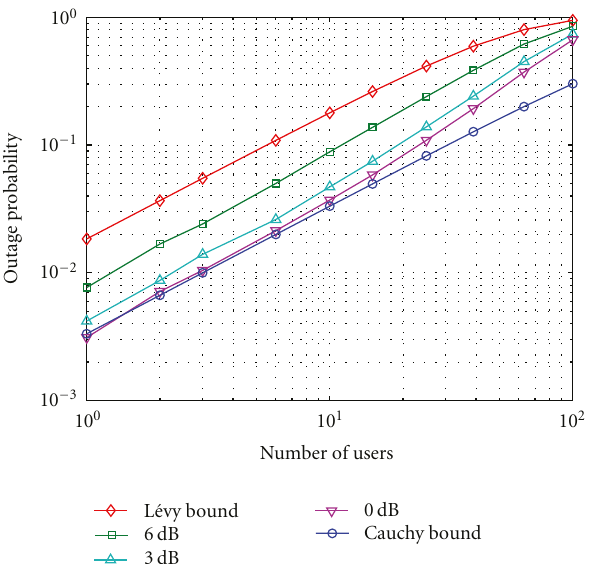
Figure 4: The outage probability P out versus the number of users N u in AWGN channels when α = 4, N s = 10, the shadowing standard derivations are, respectively, 0, 3, and